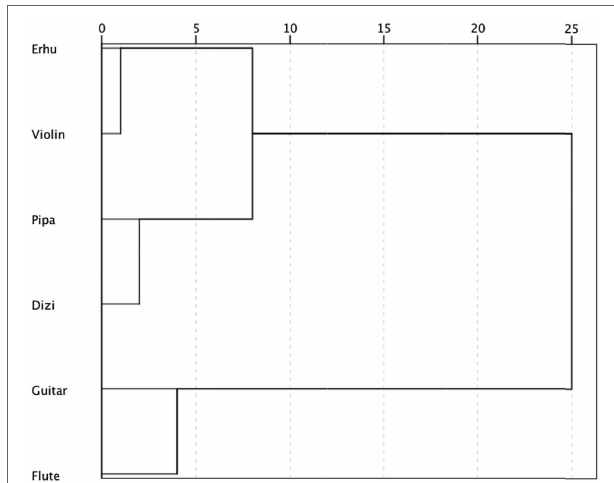
FIGURE 7 | Hierarchical cluster analysis between six instruments based on mean ratings across participants of perceived valence, tension arousal, and energy